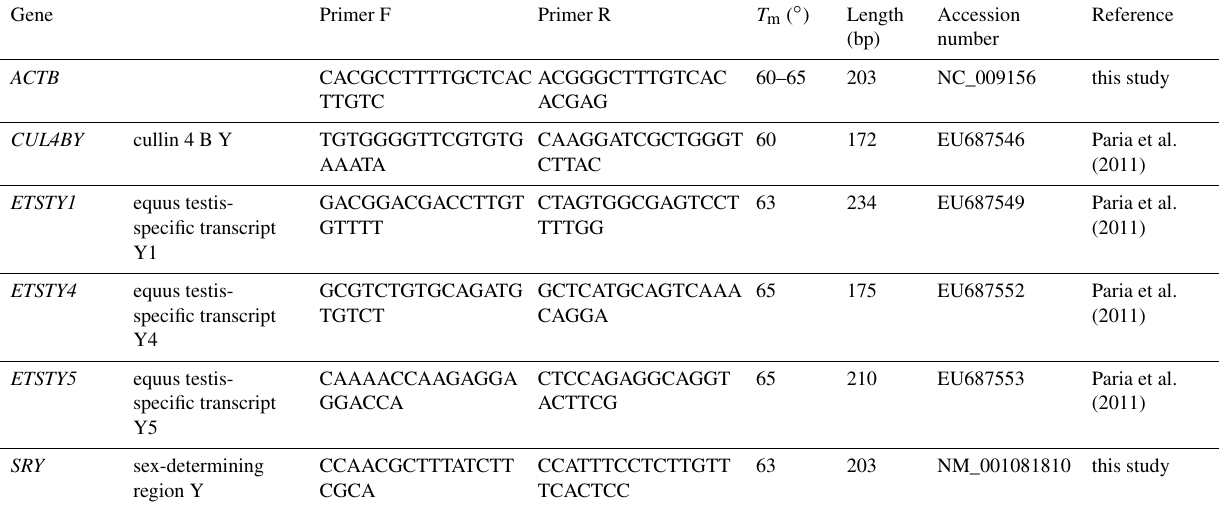
Table 2. QPCR primer information for the ACTB gene and five Y chromosome genes.